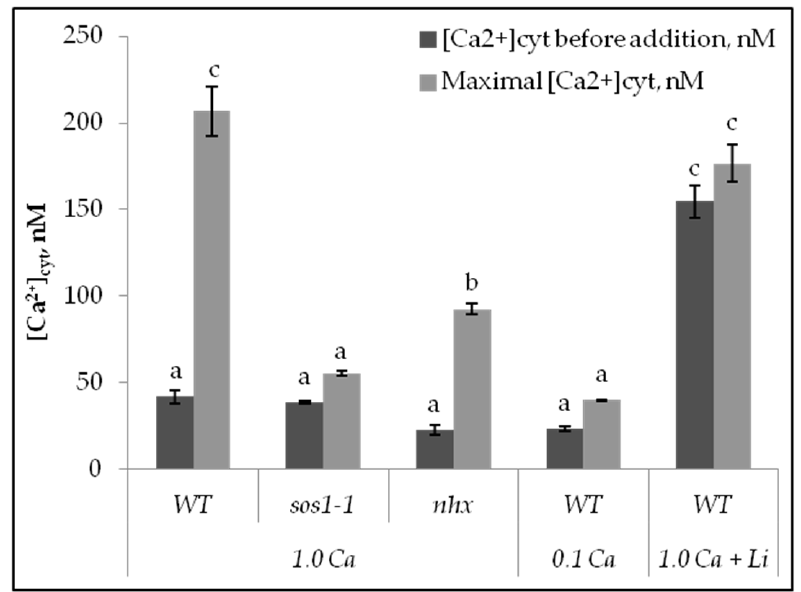
Figure 4. Changes in [Ca 2+ cyt ] in nM of mesophyll protoplasts of Arabidopsis wild type, sos1-1, and nhx1 genotypes before the addition of 100 mM of NaCl and at maximal changes of [Ca 2+ cyt ]. The external solution was with and without 5 mM LiCl and contained 0.1 or 1.0 mM Ca 2+ . Means ± SE.